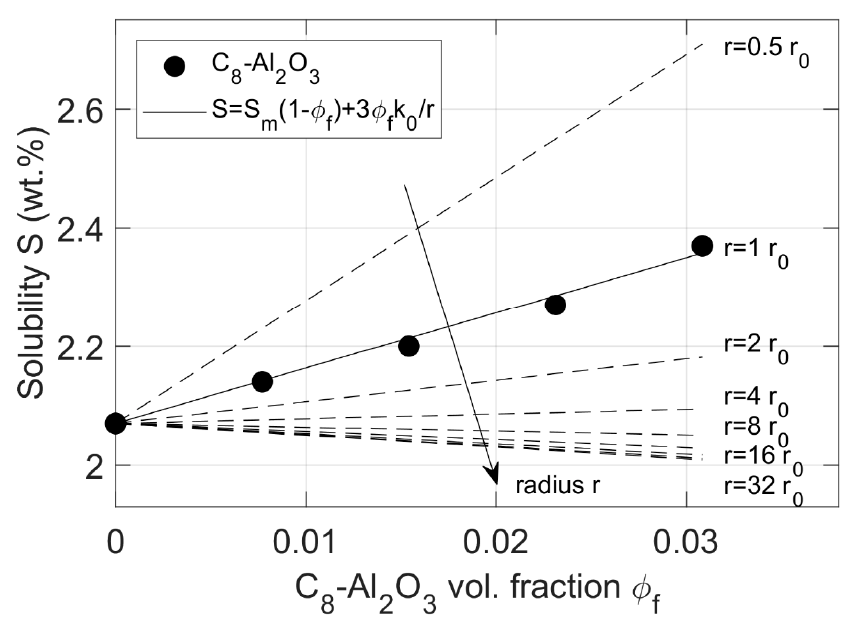
Figure 5. Acetophenone solubility (21 °C) as a function of C 8 -Al 2 O 3 vol. fraction and nanoparticle radius r . The dots are the experimental data (radius r 0 = 25 nm), while the broken lines are predictions for other particle radii (Equation (6)).